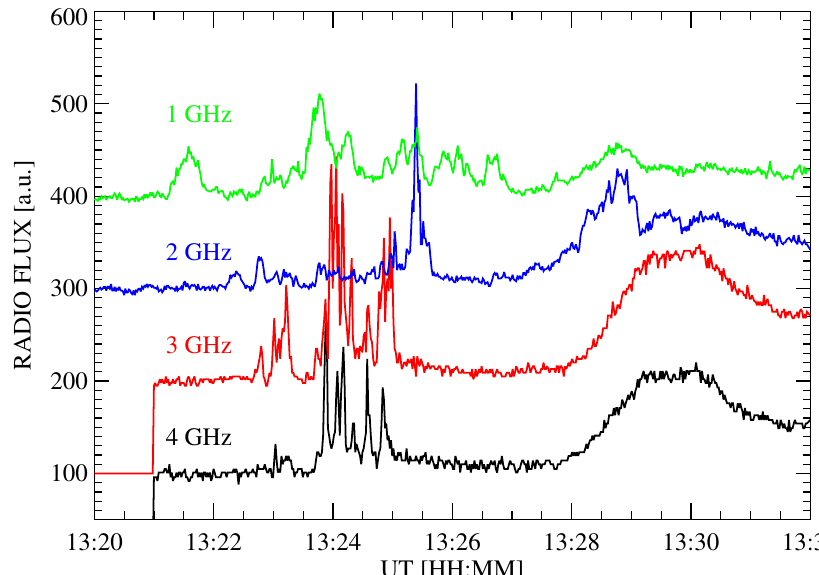
Figure 1. The X-ray and radio fluxes of the 2 April 2022 flare in the time interval 13:20–13:32UT. ( Upper ) panel: FERMI X-ray fluxes in two energy channels (24.9–49.4 and 49.9–101.4keV). ( Bottom ) panel: the radio fluxes at 4GHz (black line), 3GHz (red), 2GHz (blue) and 1GHz (green). The 3GHz,